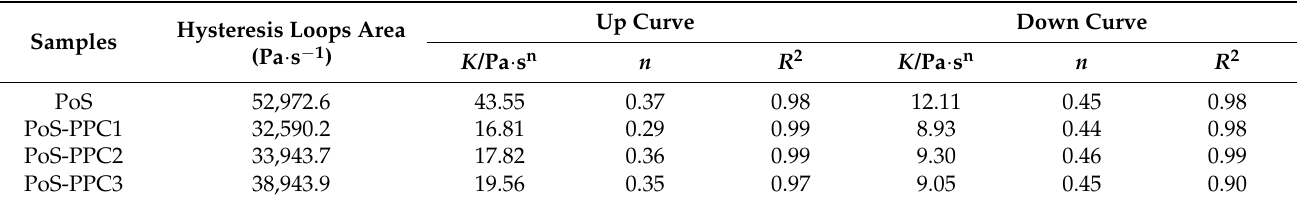
Table 2. The steady shear rheological parameters of PoS and PoS-PPC pastes modelled by the Power Law equation.